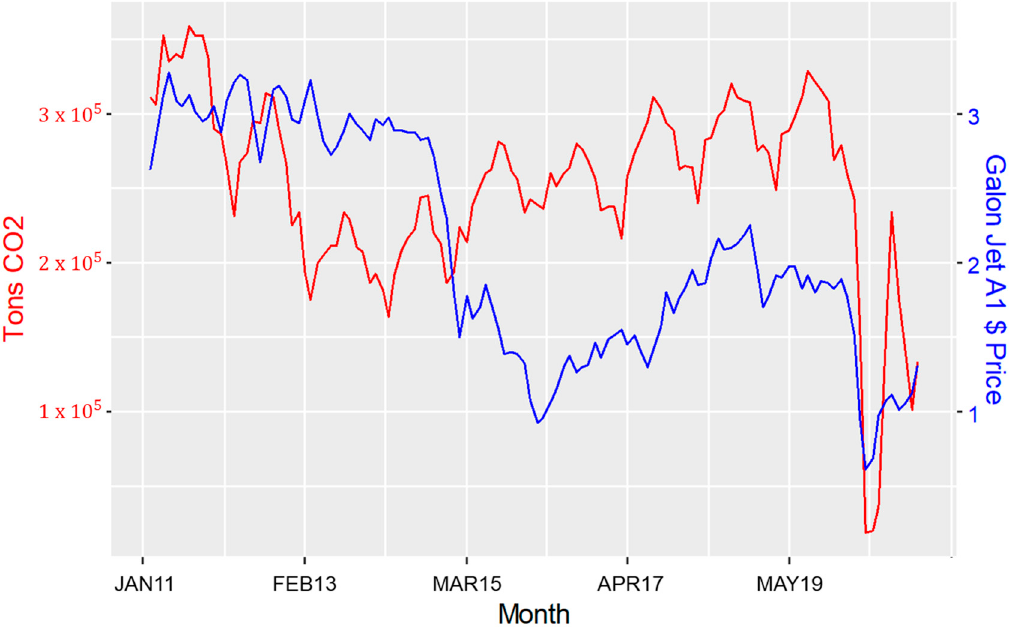
Figure 14. Comparative performance of carbon dioxide emissions and fuel prices. Source: own elaboration based on data compiled from [19] and weighted from [20] according to [28,29].